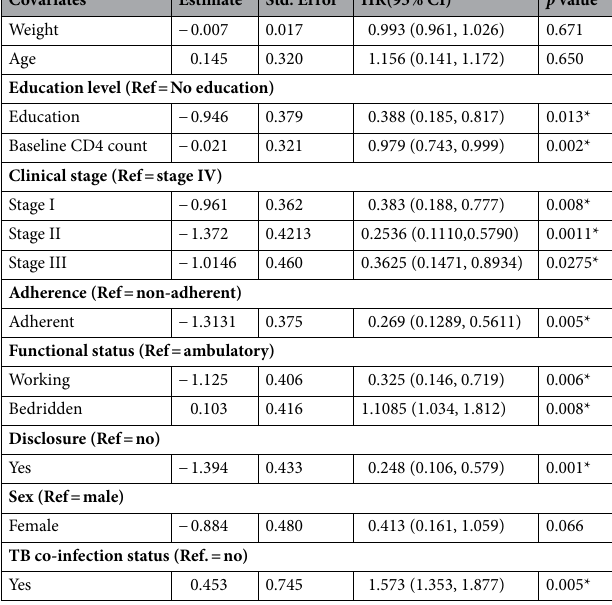
Table 3. Parameter estimates for risk for deaths (Cox proportional hazards sub-model for risk for